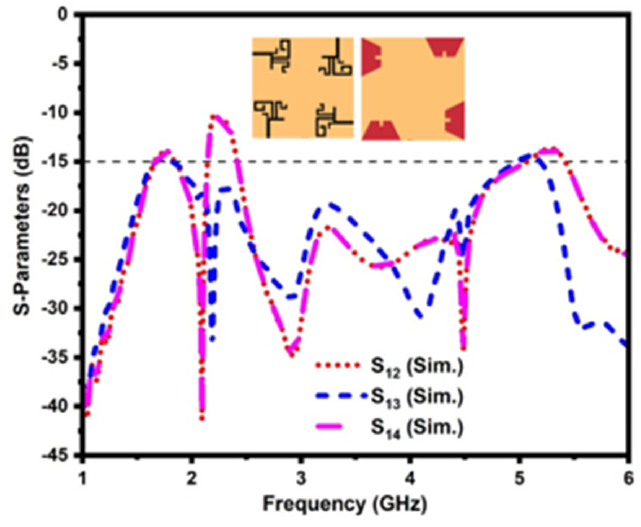
Figure 7. Mutual coupling of the conventional MIMO antenna.